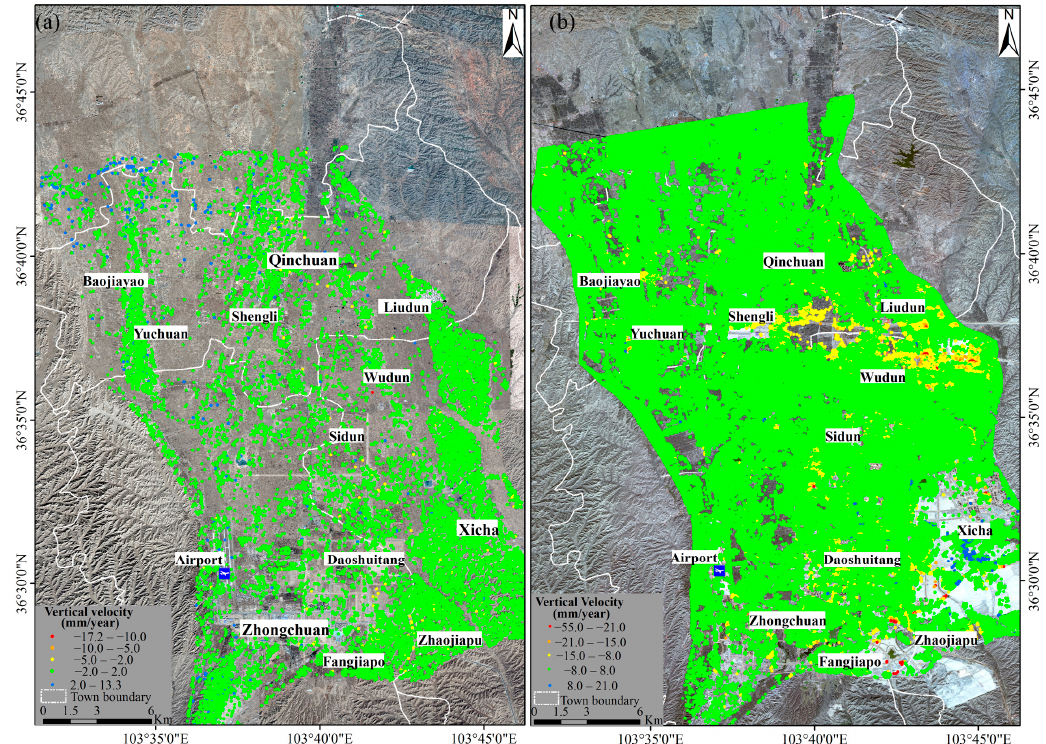
Figure 4. InSAR-derived average velocity map in the vertical direction over the LZND: ( a ) linear deformation trend of Envisat for 2003–2010 using PSI analysis, where the PS points were superimposed on the Google Earth image obtained on 3 March 2013; and ( b ) vertical velocity map of Sentinel-1A for 2015–2016 using the SBAS technique, where the CTs were superimposed on the GF-1 satellite image acquired on 17 October 2016.